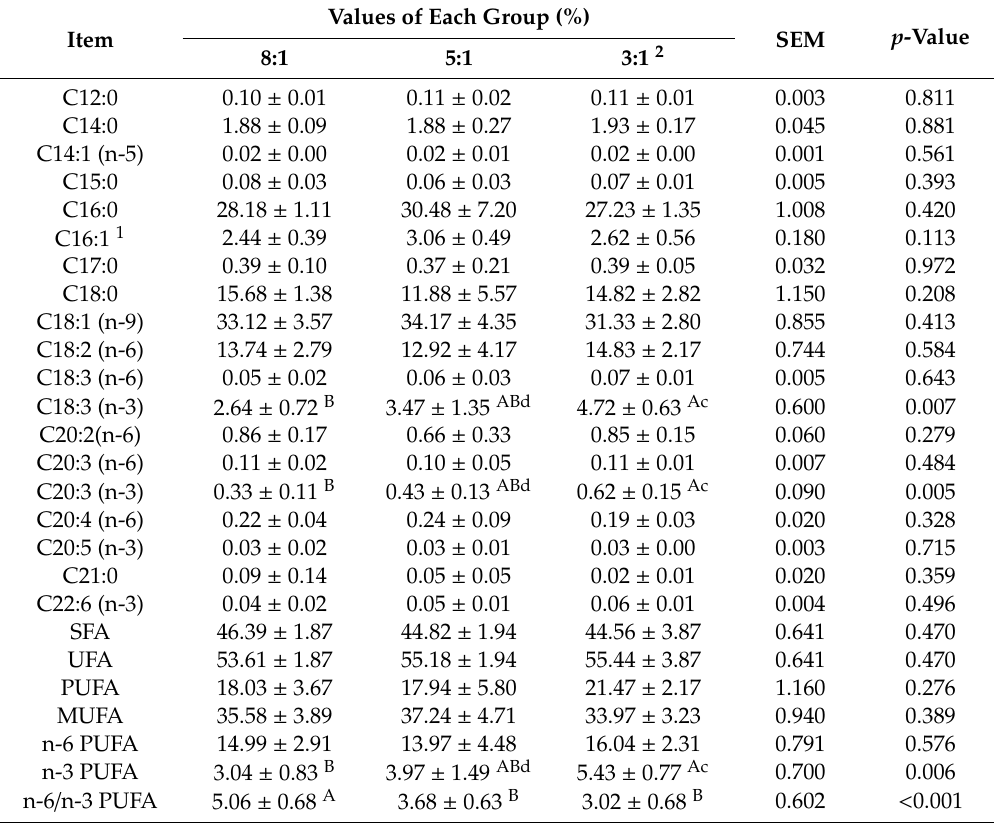
Table 6. Fatty acid profiles in SAT of Heigai pigs fed with di ff erent